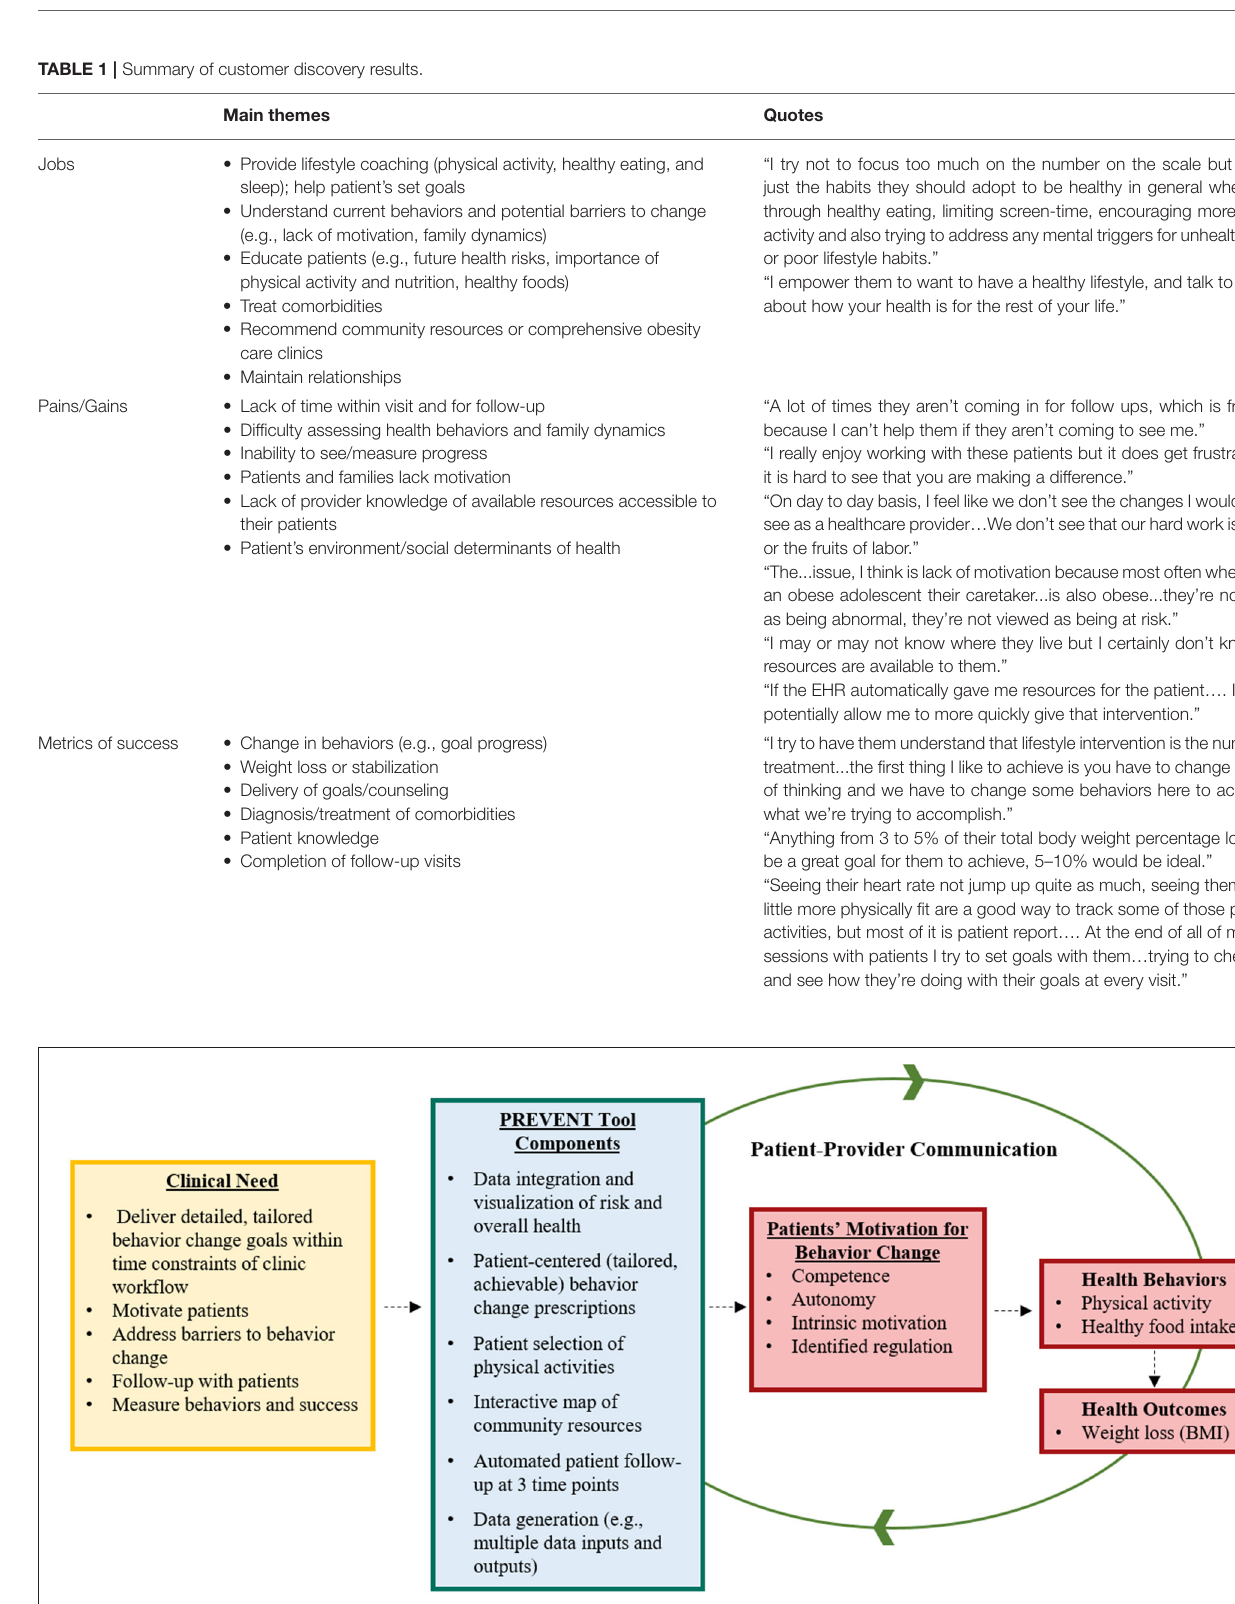
FIGURE 2 | PREVENT tool pathway of development and hypothesized